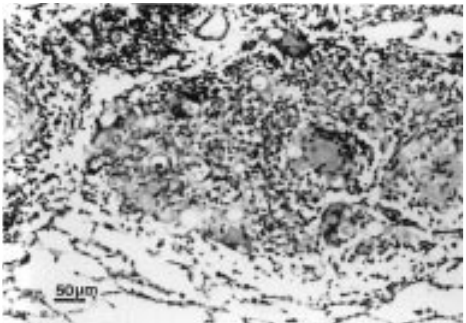
Figure 1 - Compact granulomas in the lungs of Wistar rats 60 days after inoculation with P. brasiliensis (hematoxylin and eosin, left = 200X, right = 400X).